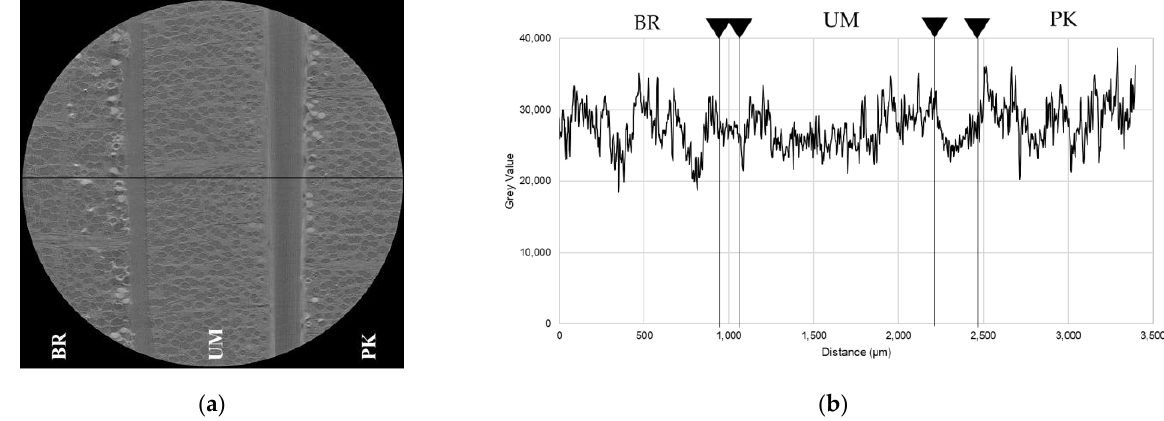
Figure 6. Sample Series 1 Cu target down side (BR, UM, PK); ( a ) visualization result and the plot-profile line; ( b ) plot profile graphic.